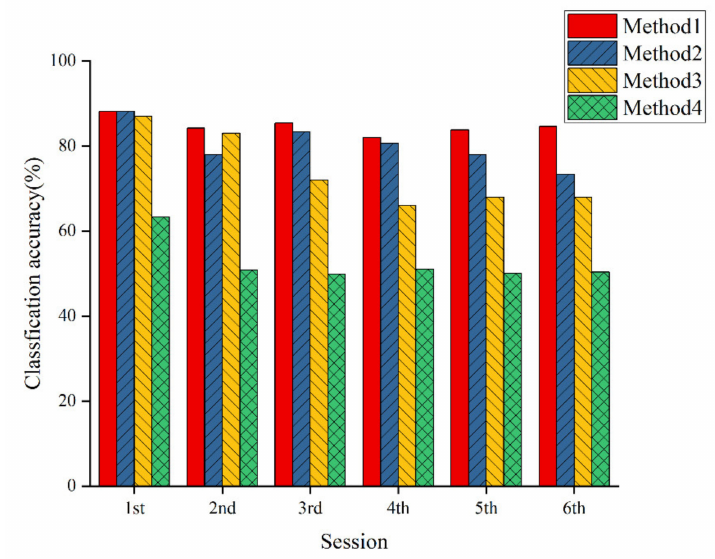
Figure 7. Classification accuracy